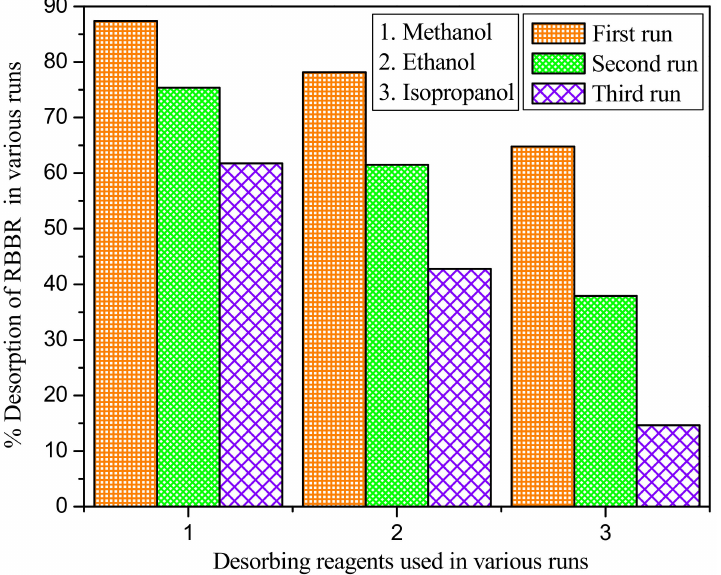
Figure 16. Desorption efficiency of RBBR dye from WSBAC adsorbent in various runs. (Volume of desorbing reagent: 0.1 L; shaking speed: 150 rpm; temperature: 301 K; contact time: 24